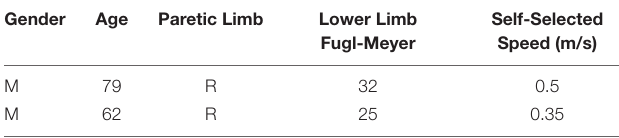
TABLE 1 | Clinical characteristics of study participants.